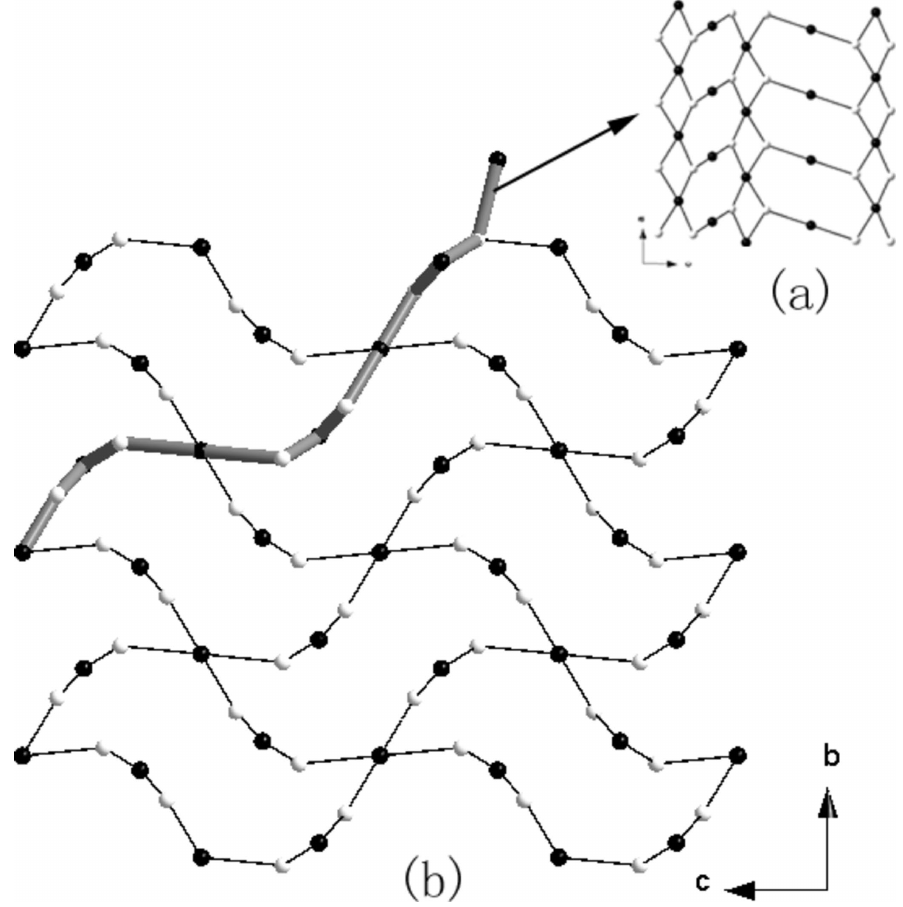
The 16-membered polyhedral ring channels of (I), filled with Na + counter cations.